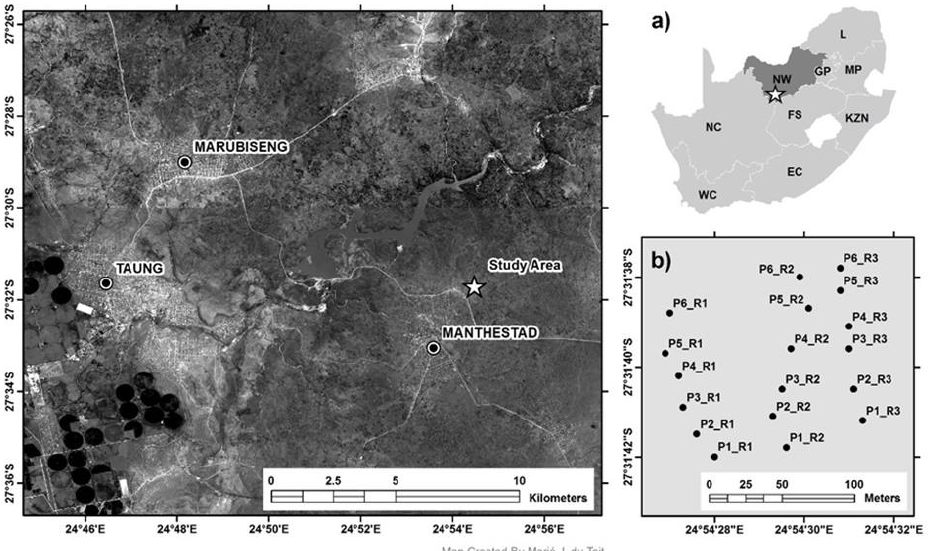
Fig. 1. Location map indicating the study area in the Greater Taung Municipality, North West Province (Source: Google Earth, Marie du Toit) (Fig. 1b: P – Plot; R – Row; 1, 2, 3 … – Plot or Row